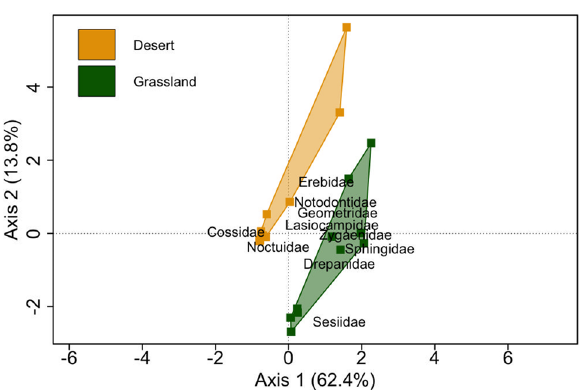
Figure 4. Correspondence analysis of the major families sampled from all sites separated markedly desert (yellow polygon) and grassland (green polygon) sites. Noctuidae and Cossidae were more associated with desert sites, whereas other families were associated with grassland sites. First two axes of the graph together explain 76.2% of the